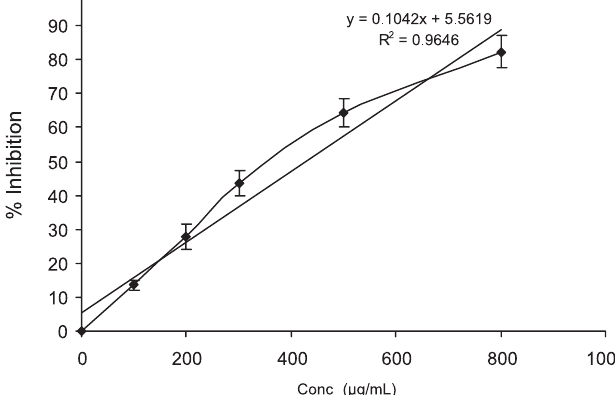
FIGURE 1 - In vitro Antioxidant activity of MELC using DPPH